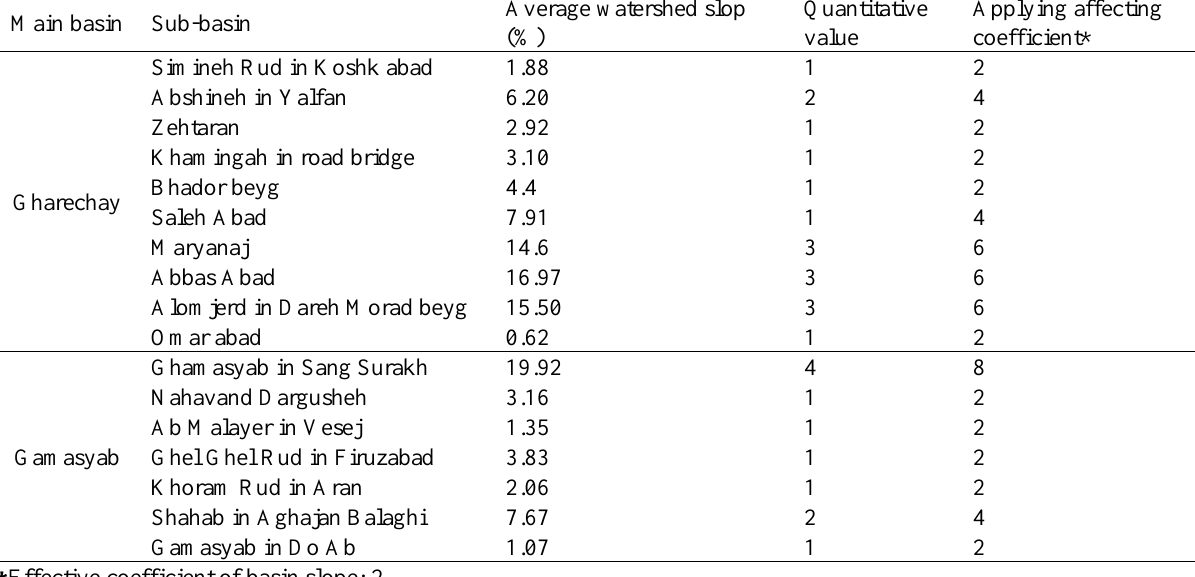
Table 3. Slope of Gamasyab and Gharechay sub-basins with quantitative coefficients Main basin Sub-basin